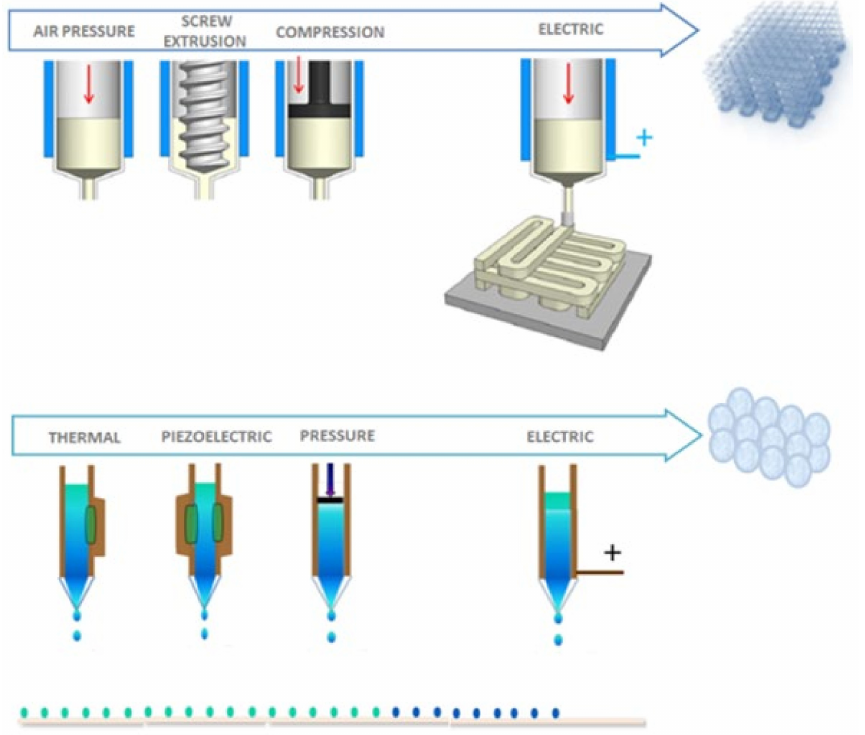
Figure 7. Scheme of different additive manufacturing technologies used for the processing of nanocellulose-based materials—image adapted from